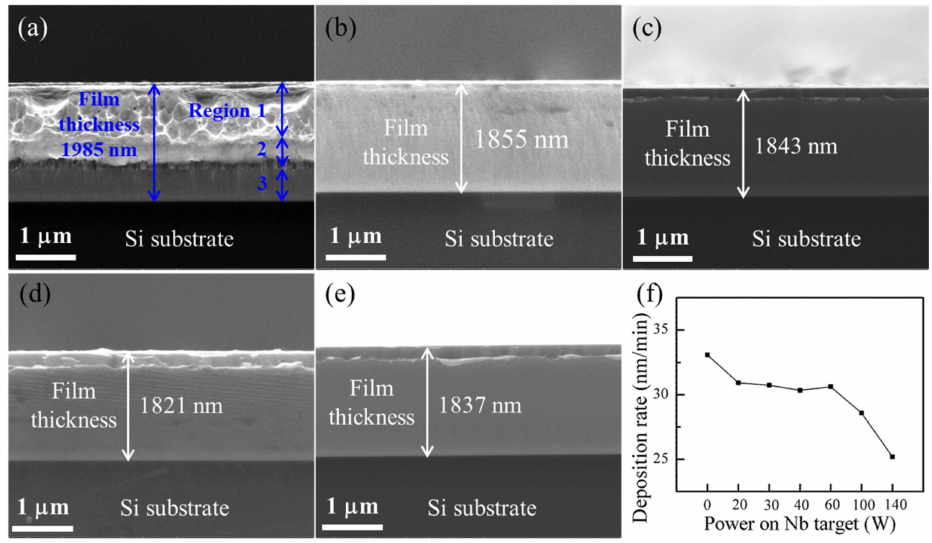
Figure 1. FE-SEM cross-section micrographs of the Nb x -CoCrFeMnNi HEAFs with various Nb concentrations: ( a ) 0, ( b ) 0.6, ( c ) 1.8, ( d ) 4.1, and ( e ) 7.2 at.%. ( f ) The deposition rate as a function of the sputtering power applied on the Nb